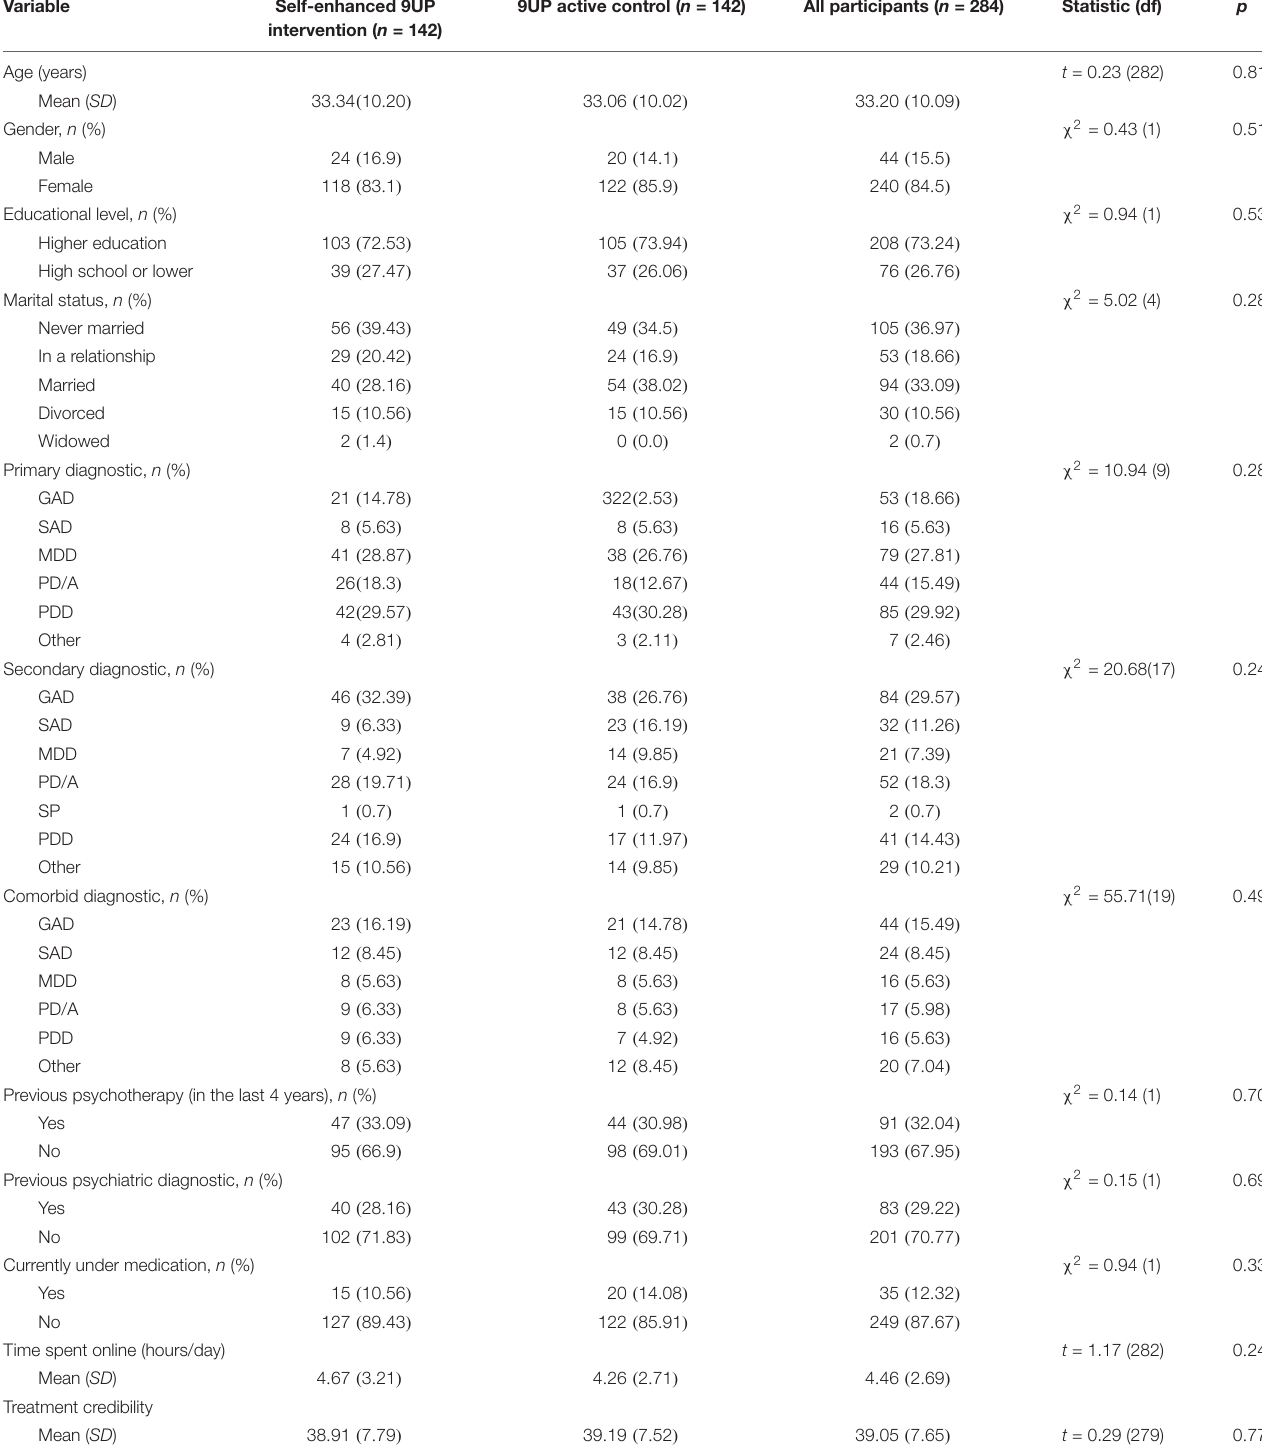
TABLE 2 | Baseline characteristics of the participants in the two groups and the entire sample. Variable Self-enhanced 9UP 9UP active control ( n = intervention ( n = 142)